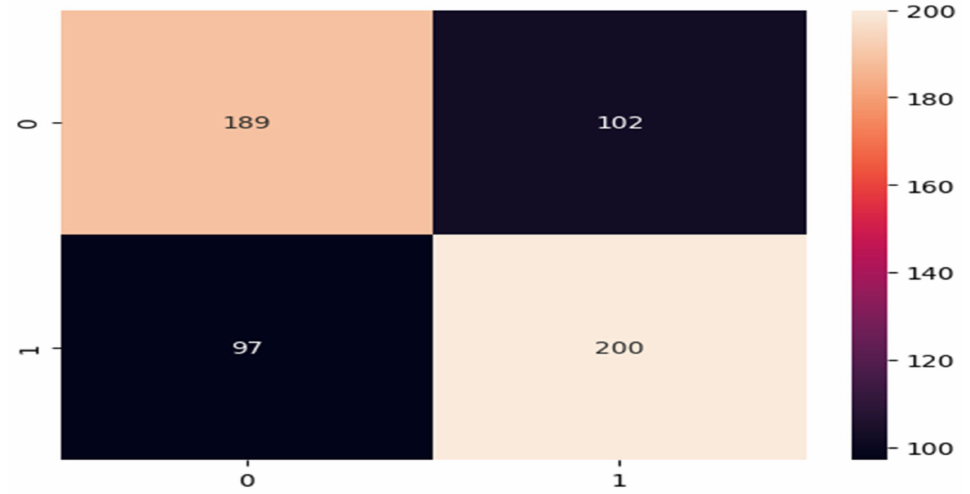
Figure 14. Confusion matrix of VGG-16 with decision tree.